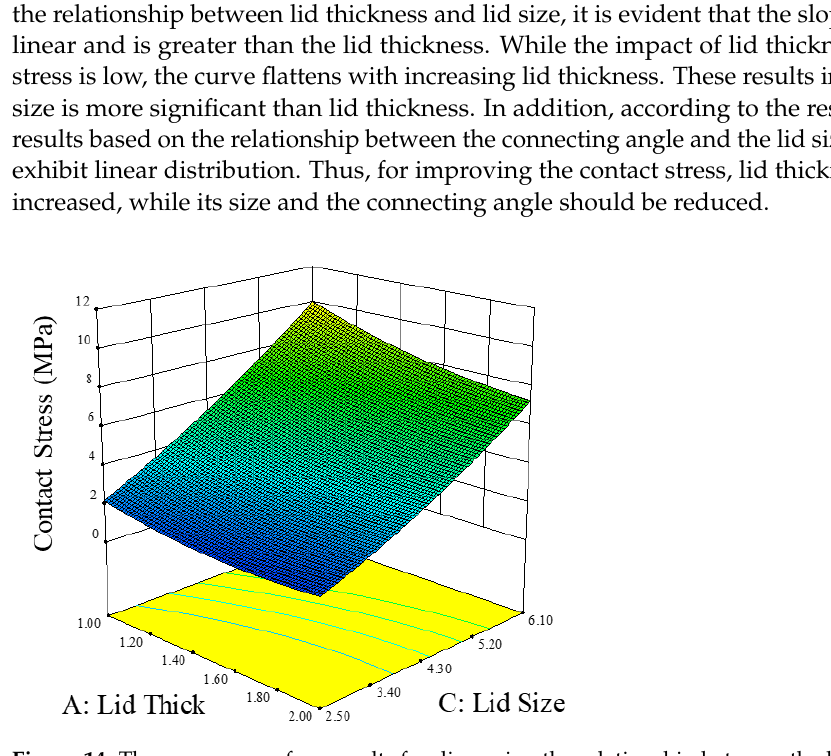
Figure 13. One factor design for discussing the material property effect.